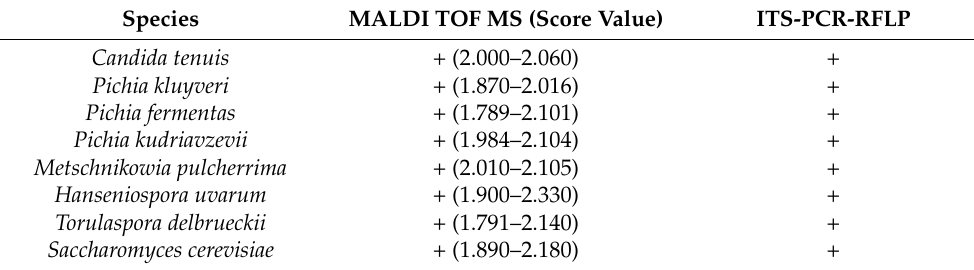
Table 2. Identified yeast species from examined soil samples, leaves, berries, must, and new wine. Species